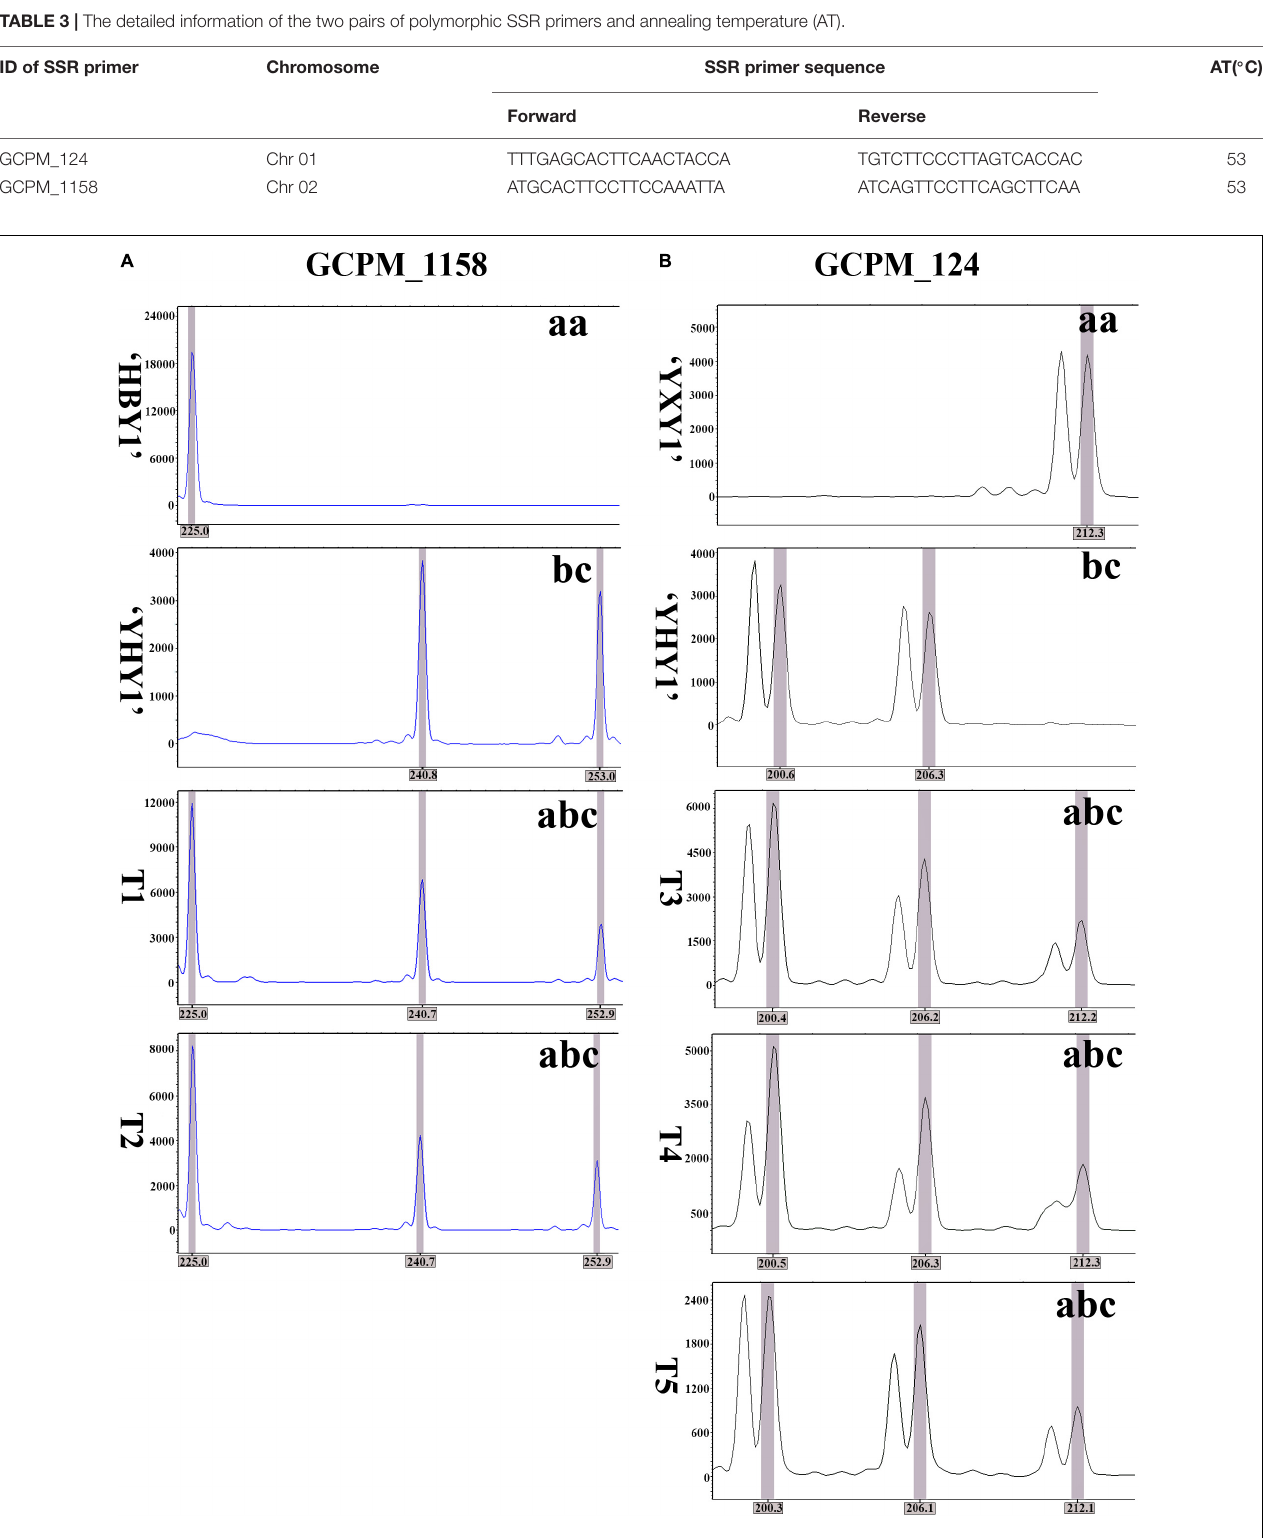
FIGURE 7 | Genetic constitutions of the colchicine-induced 2n pollen in P. canescens were revealed by capillary electrophoresis of the loci of primers GCPM_1158 and GCPM_124. (A) Allelic configuration in triploid progeny derived from P. hopeiensis × P. canescens and their parents. T1 and T2 indicate hybrid triploids. (B) Allelic configuration in triploid progeny derived from ( P. alba × P. glandulosa ) × P. canescens and their parents. T3, T4, and T5 also indicate three hybrid triploids.